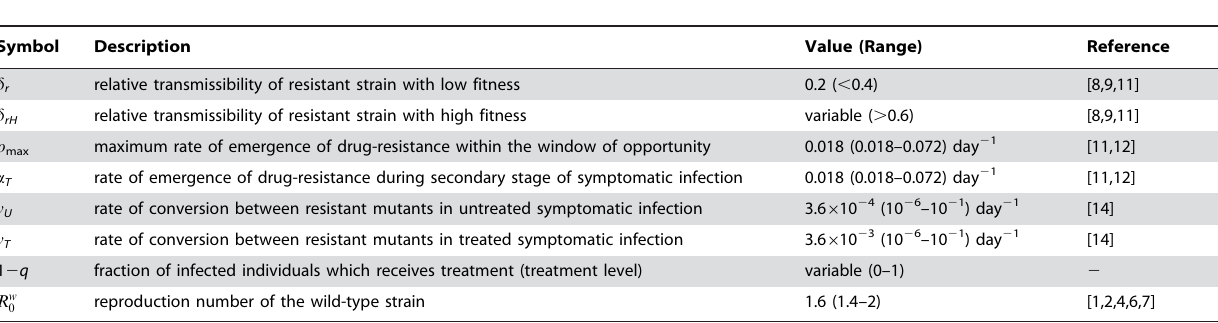
Table 1. Description of transmission, mutation, and treatment parameters of the model with their baseline values and ranges used for simulations and sensitivity